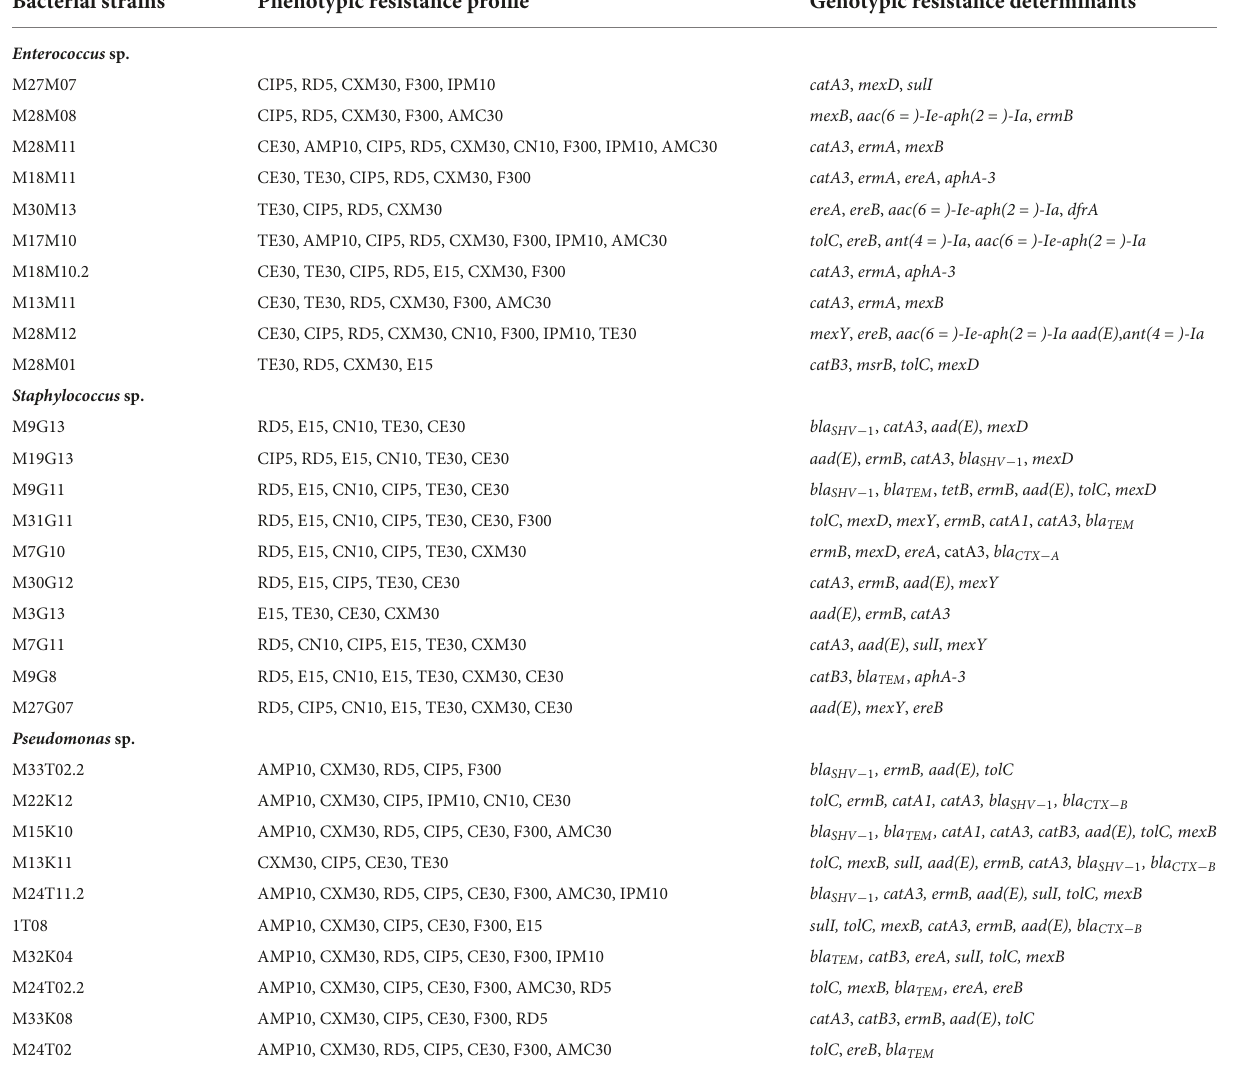
TABLE 3 Phenotypic and genotypic antibiotic resistance profile of bacterial strains isolated throughout meat chain production in a lamb and goat slaughterhouse of Jaén. Bacterial strains Phenotypic resistance profile Genotypic resistance determinants Enterococcus